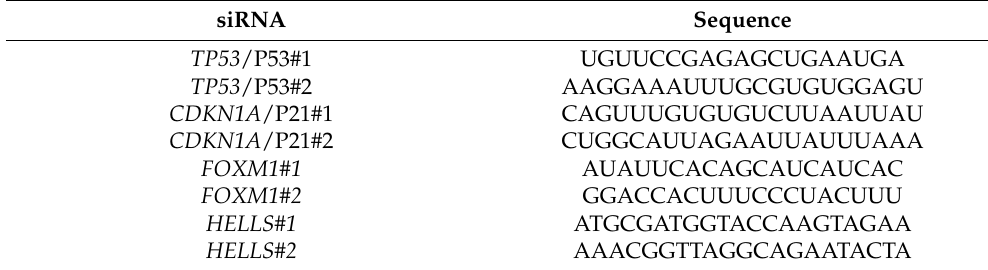
Table 1. Sequences of siRNAs used in the